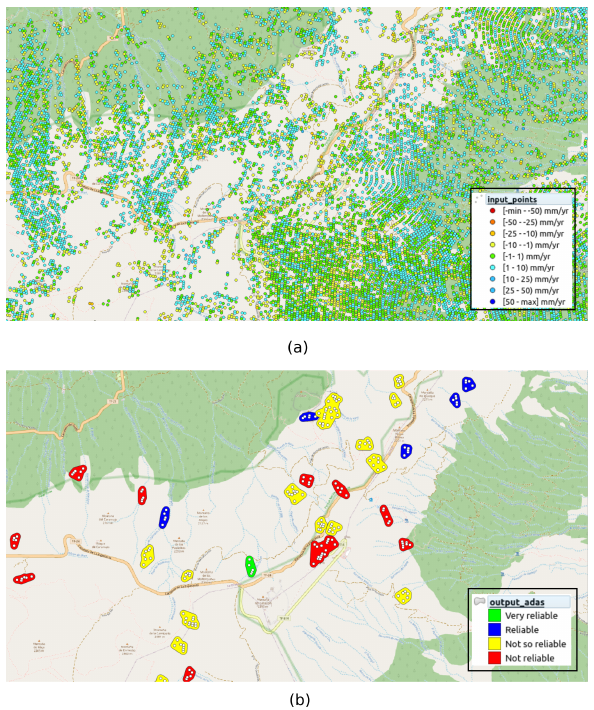
Figure 1. The number of PS covering an area (a) may be very big. The ADA (b) are more manageable and convey much more useful